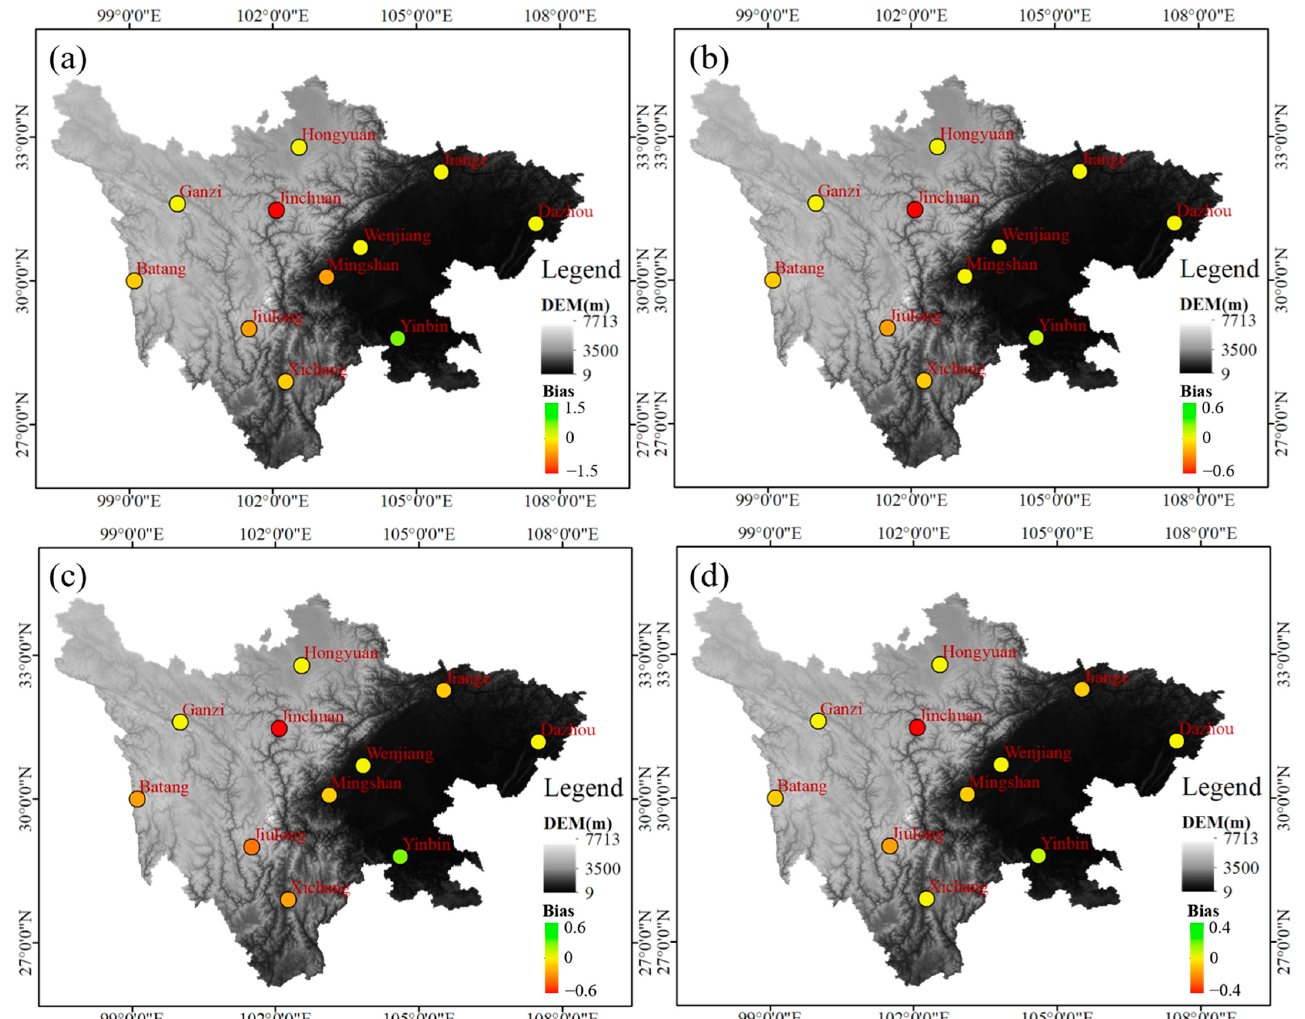
Figure 5. Spatial distribution of Bias and DEM. ( a ) Whole layer; ( b ) high layer; ( c ) middle layer; ( d ) low layer.